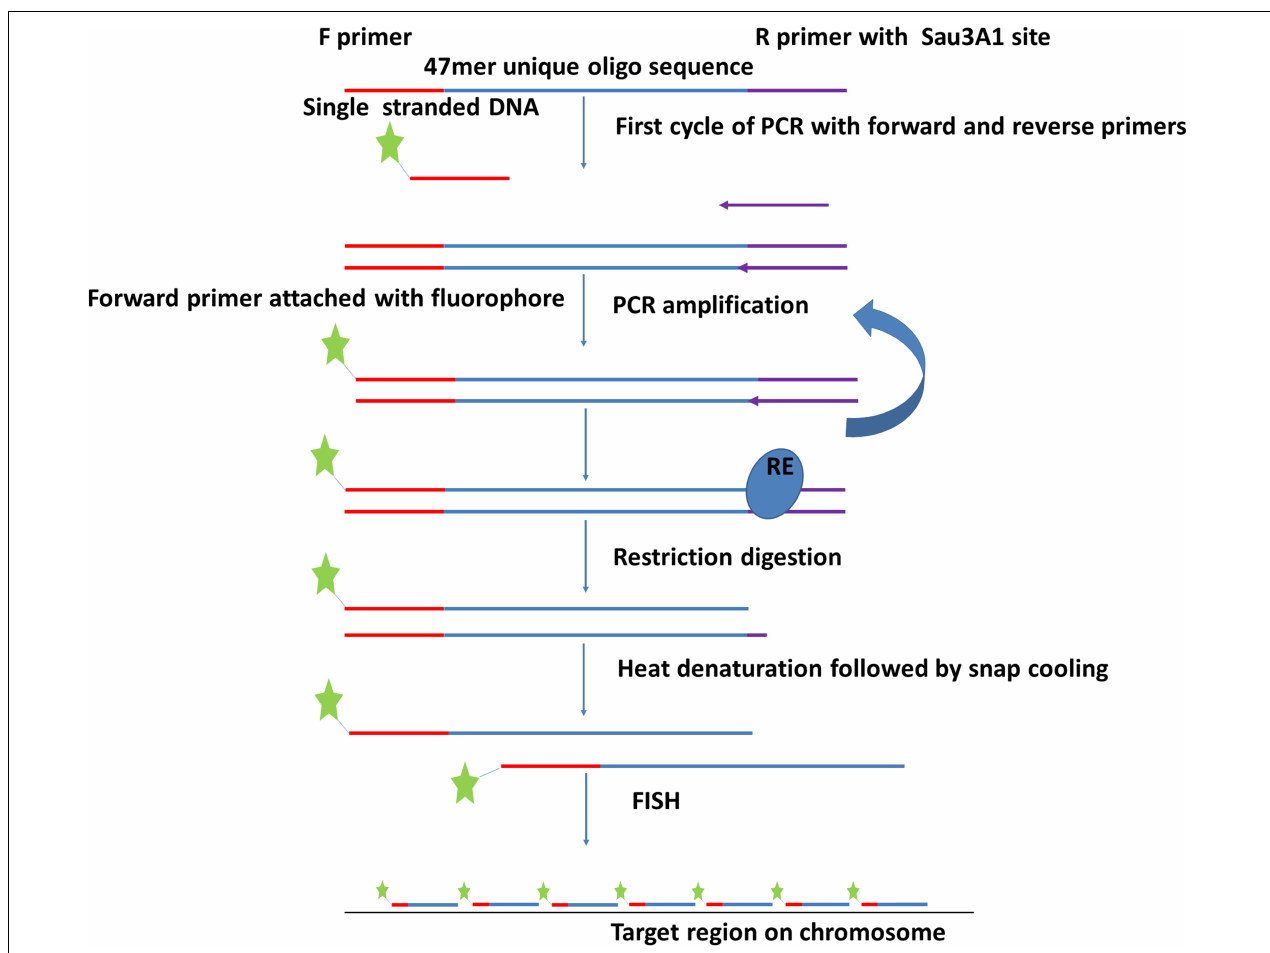
FIGURE 2 | Flowchart depicting procedure for amplification of oligonucleotide libraries (immortalization). The oligonucleotides ( Figure 1 ) are synthesized with 5 (cid:48) and 3 (cid:48) primers and amplified by PCR using one labeled and one unlabeled primer. After restriction enzyme digestion to remove the unlabeled end complementary to the reverse primer, the labeled product is hybridized to chromosome